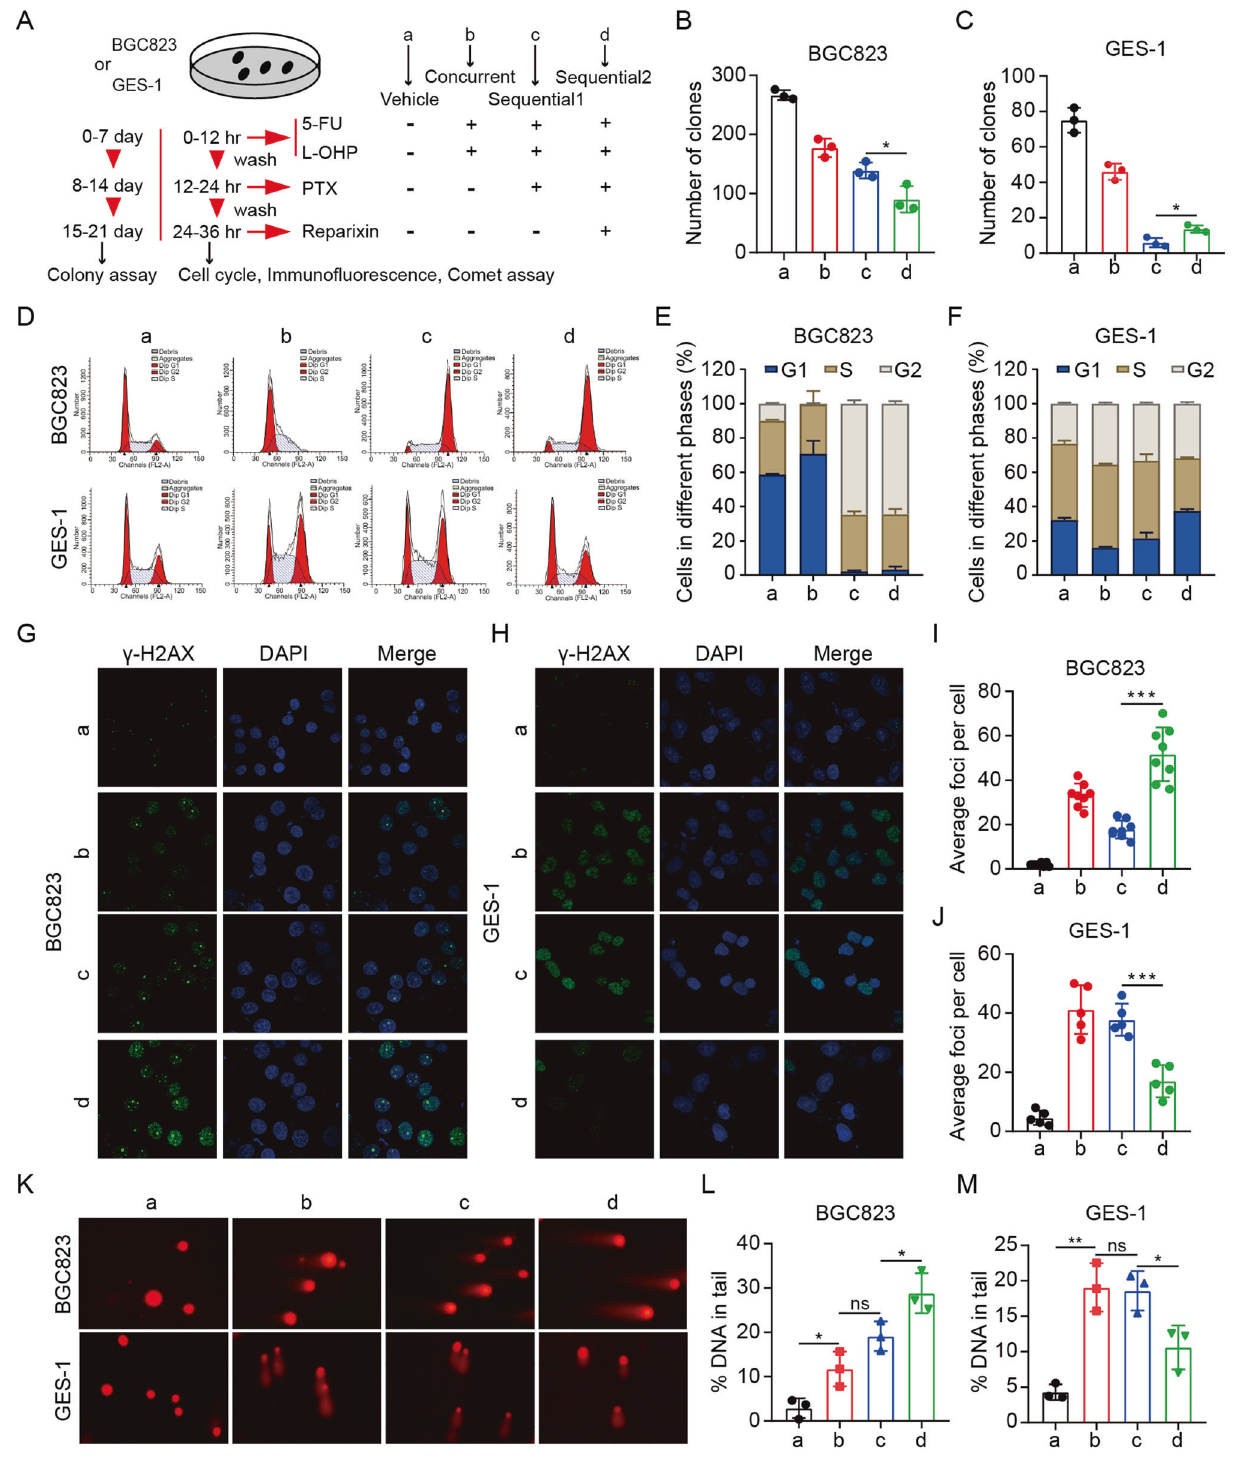
Fig. 4 Sequential treatment with fi rst-line, second-line chemotherapy, and reparixin preserves ef fi cacy to GC cells and ameliorates toxicity to normal cells. A Schematic representation of sequential treatment with fi rst-line, second-line chemotherapy, and reparixin in BGC823 or GES-1 cells. B , C Colony formation assays were performed on BGC823 and GES-1 cells treated with different drugs as in Fig. 4A. Data are mean ± standard deviation. * P < 0.05. D – F BGC823 and GES-1 cells were treated as in Fig. 4A and subjected to fl ow cytometric analysis. G – J Representative images ( G , H ) and quanti fi cation ( I , J ) of BGC823 and GES-1 cells treated as in Fig. 4A and then stained for γ H2AX and DAPI. Data are mean ± standard deviation. *** P < 0.001. K – M BGC823 and GES-1 cells were treated as in Fig. 4A and subjected to Comet analysis. DNA damage is quanti fi ed as percent DNA in tails. Data are mean ± standard deviation. * P < 0.05, ** P < 0.01.